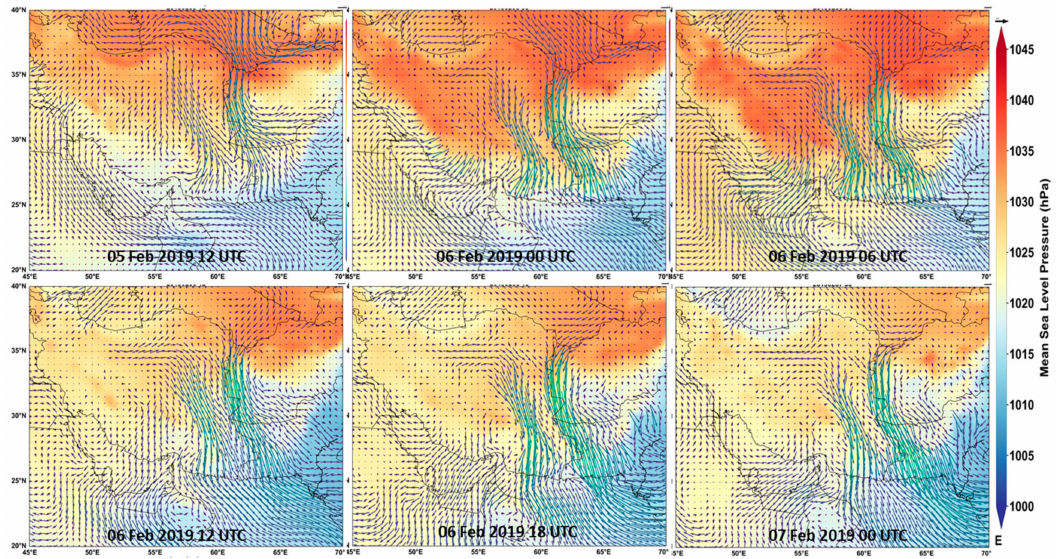
Figure 4. Mean sea level pressure (MSLP) variations superimposed with 850 hPa winds over southwest Asia on certain hours during 5–7 February 2019 according to ERA-Interim